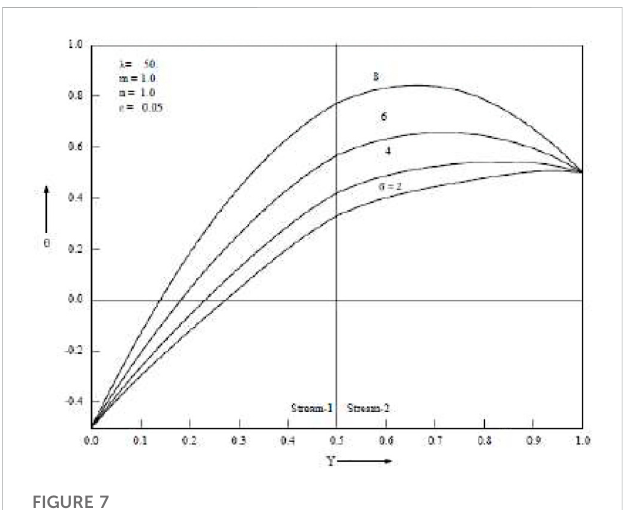
FIGURE 9 Velocity for various values of σ = 2, 4, 6,